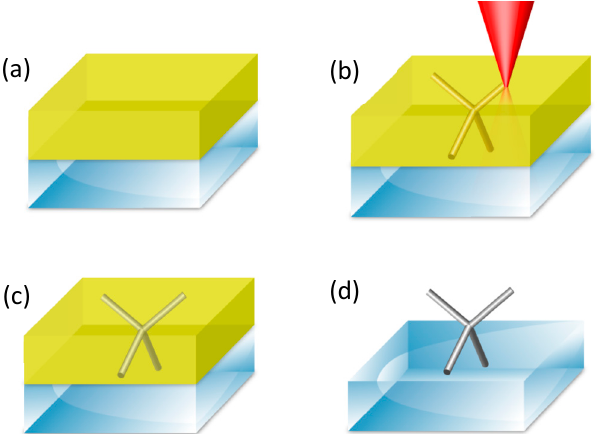
Figure 3. Use of TPL and electrochemical deposition to fabricate 3D magnetic nanostructures. ( a ) Spin-coating of a positive resist onto a conductive substrate; ( b ) Two-photon lithography of a 3D structure into the positive resist; ( c ) Electrodeposition of magnetic material into the channels; ( d ) Lift off of the resist.